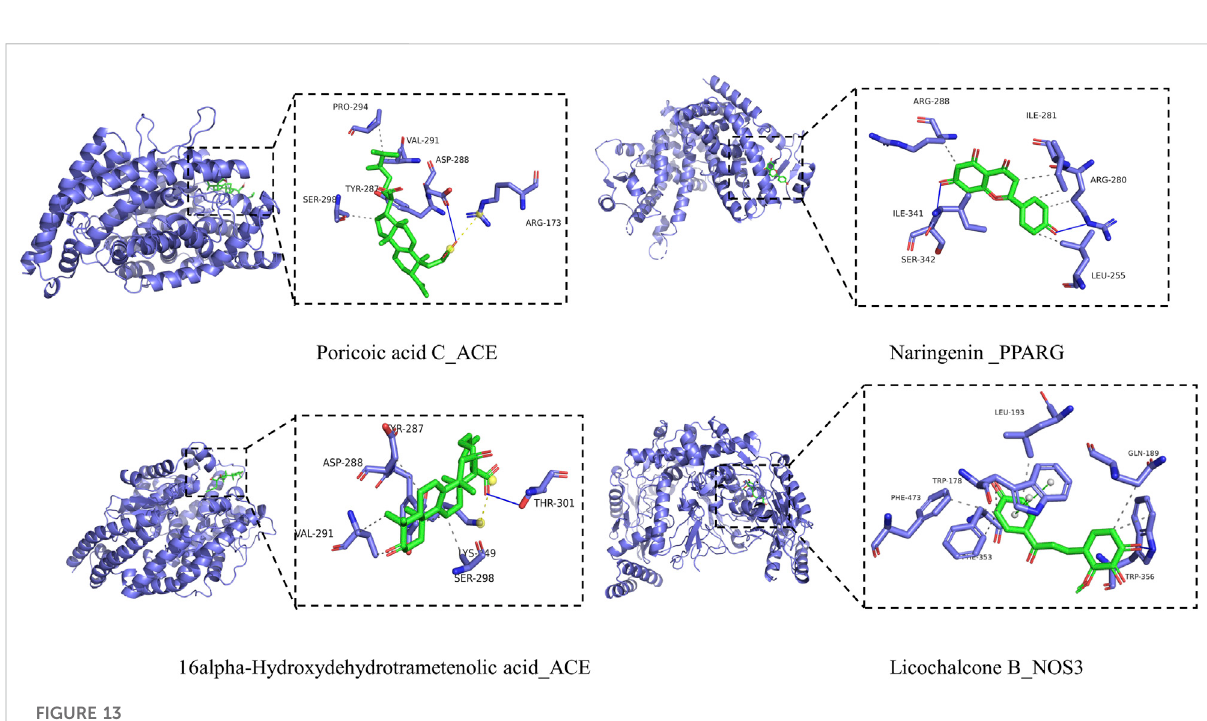
FIGURE 13 Molecular docking of key targets and key